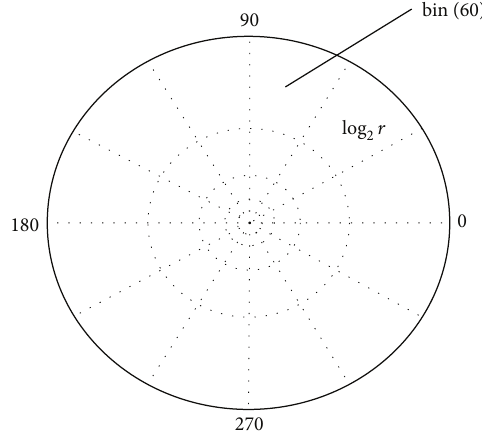
Figure 7: Schematic diagram of log-polar coordinate.